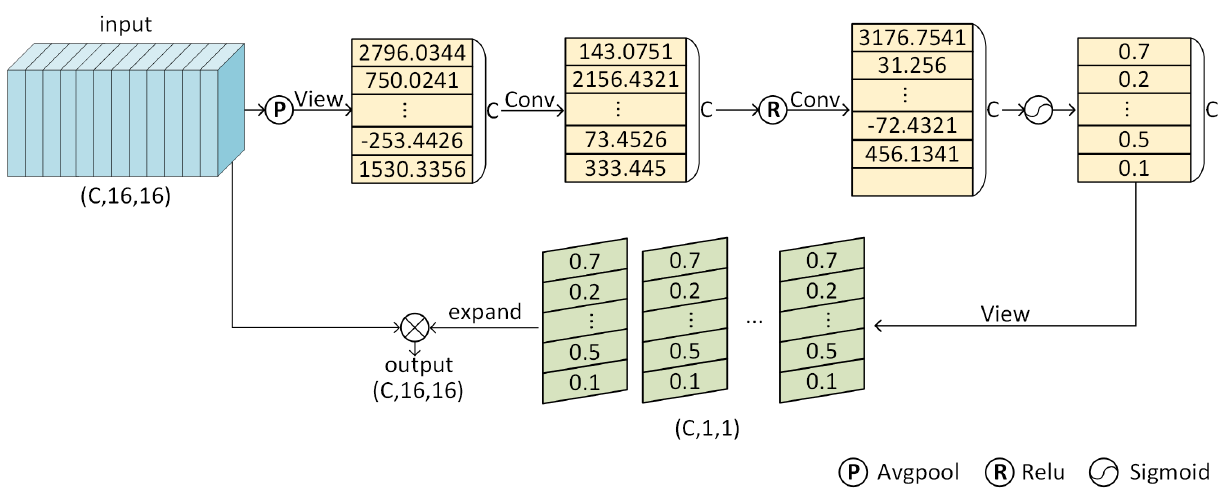
Figure 3. A diagram of the channel-wise attention